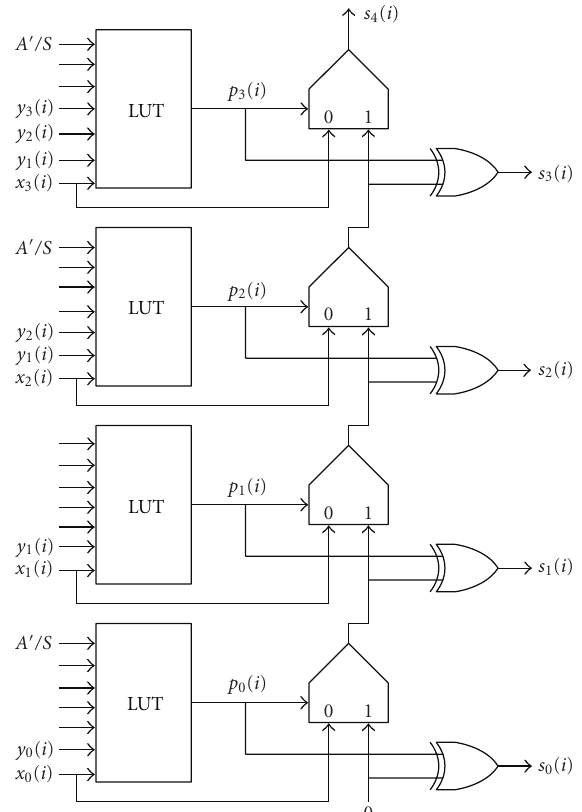
Figure 16: FPGA implementation of the adder stage for a 10’s complement BCD